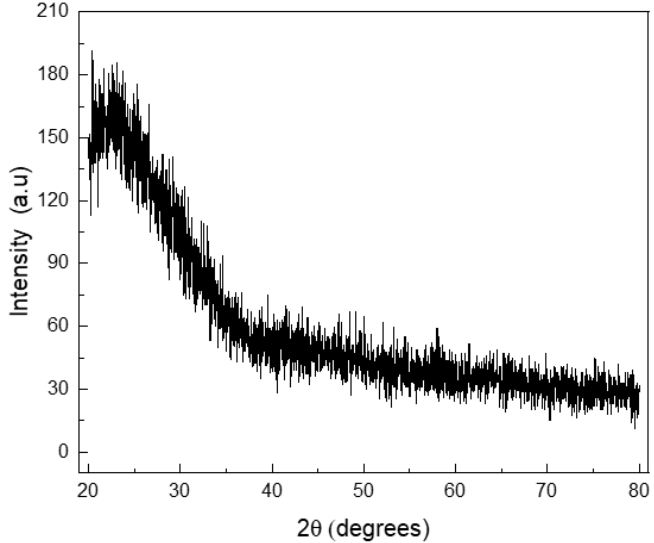
Figure 1. X-ray diffraction pattern for the mesoporous bioactive glass particles synthetized.